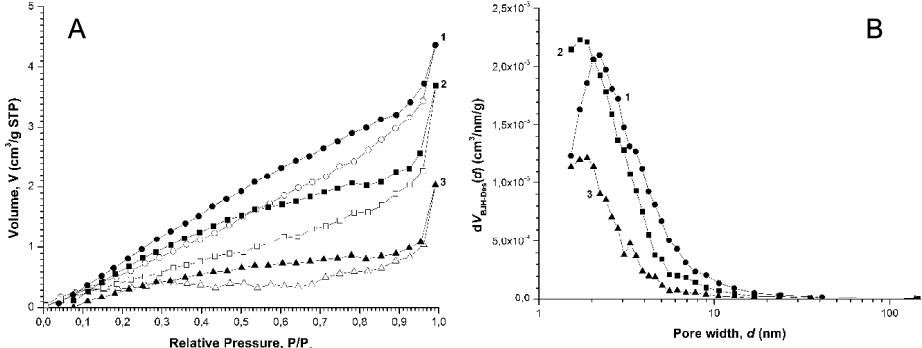
Figure 6. Full nitrogen adsorption (white)–desorption (black) isotherms ( A ) and their corresponding pore size distributions d V( D ); ( B ) obtained from the treatment of full nitrogen adsorption–desorption isotherms within the BJH model: (here and in Figure 7) moraine samples from polygons K1 (1) and K3 (2—internal, less weathered part; and 3—surface, more weathered part of the same boulder). Table 1. Parameters of the mesostructure of the moraine samples obtained from the analysis of SANS ( D S = 6 − n ) and low- temperature nitrogen absorption data ( S BET, d p, and V P / P 0 0.99 ).